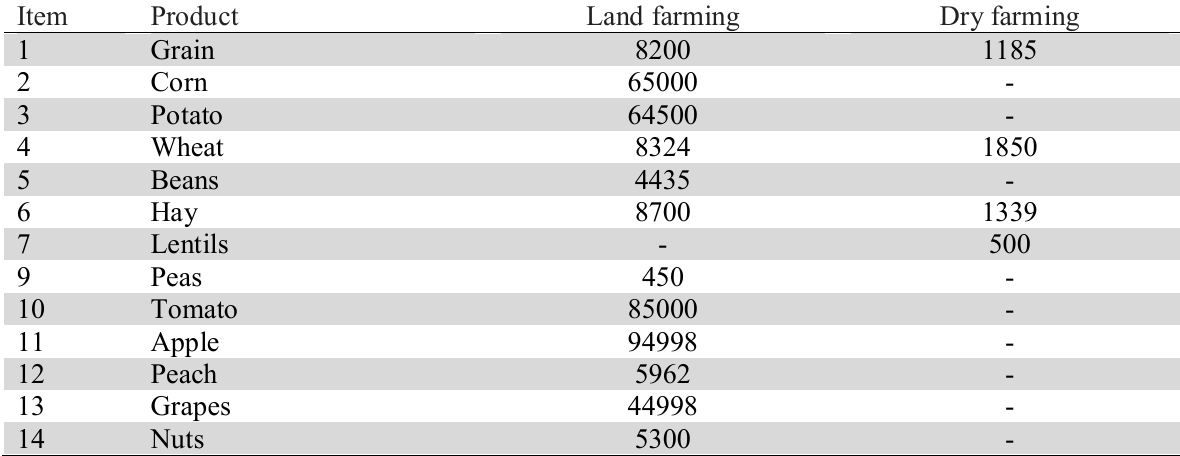
The maximum amount of products obtained based on two systems in terms of kilogram per hectare